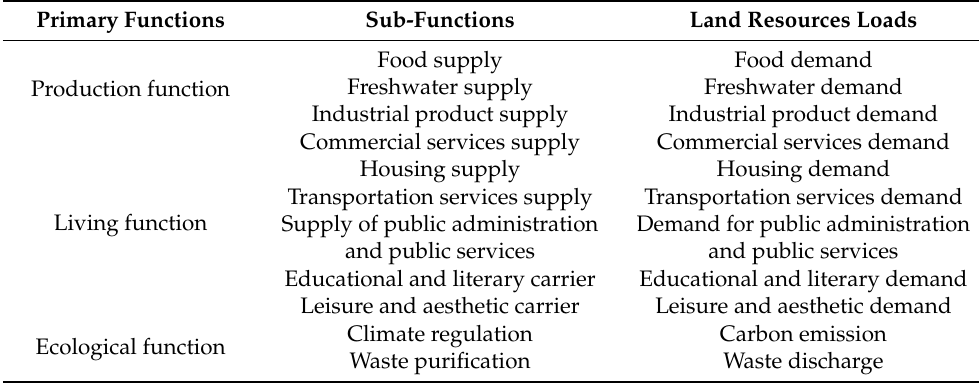
Table 3. Land resources